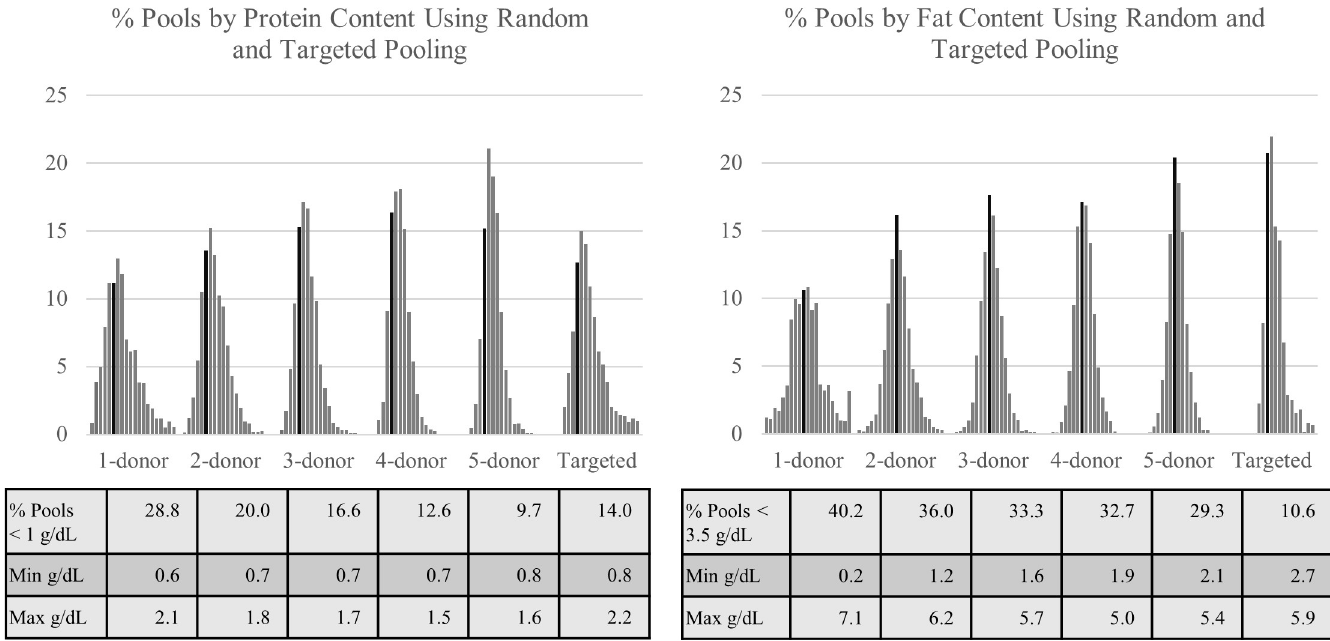
Fig 3. Percent of pools by protein and fat content based on random pooling of 1 to 5 donors, or targeted pooling. Dark bar represents percent of pools containing 1.0 g/dL of protein and 3.5 g/dL of fat.